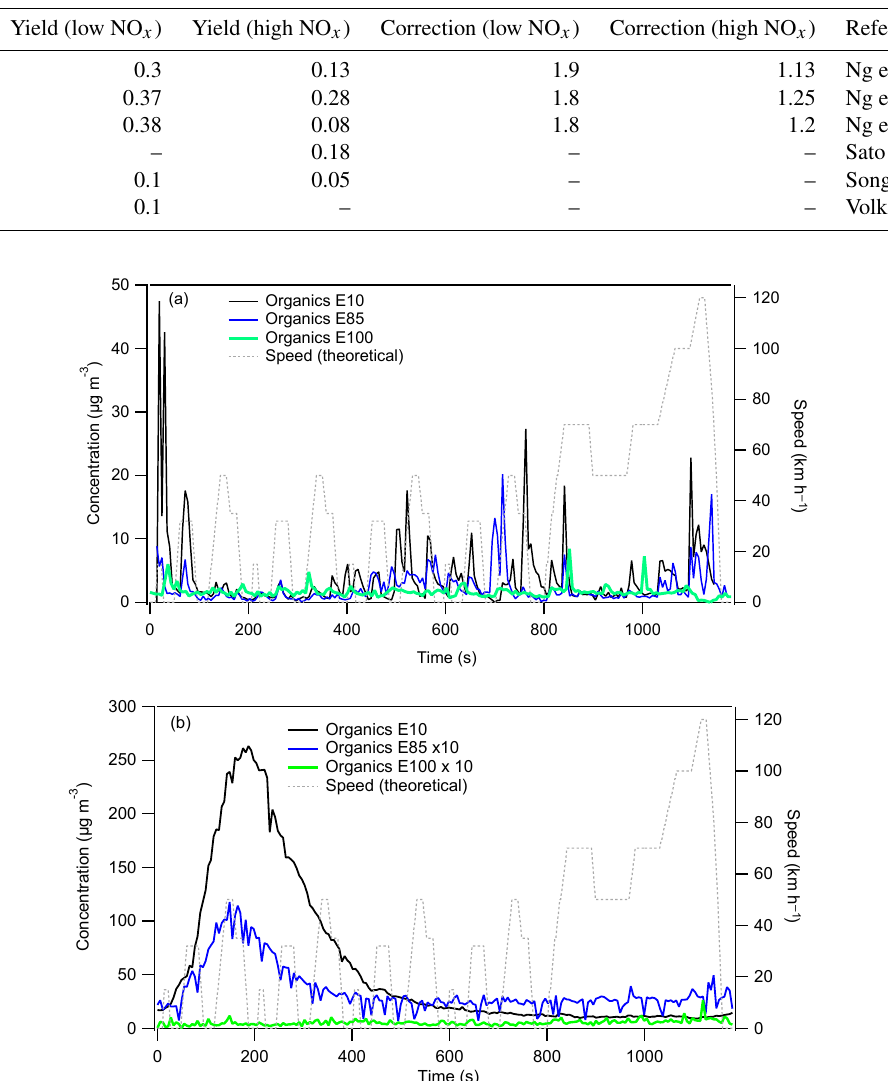
Figure 7. The time series of the organic compounds for the primary emissions (a) and for the emissions measured after the PAM chamber (b) . The speed profile of the NEDC is also shown. The speed profile and the mass concentration in (b) do not correspond to each other directly due to the broad residence time distribution of the PAM